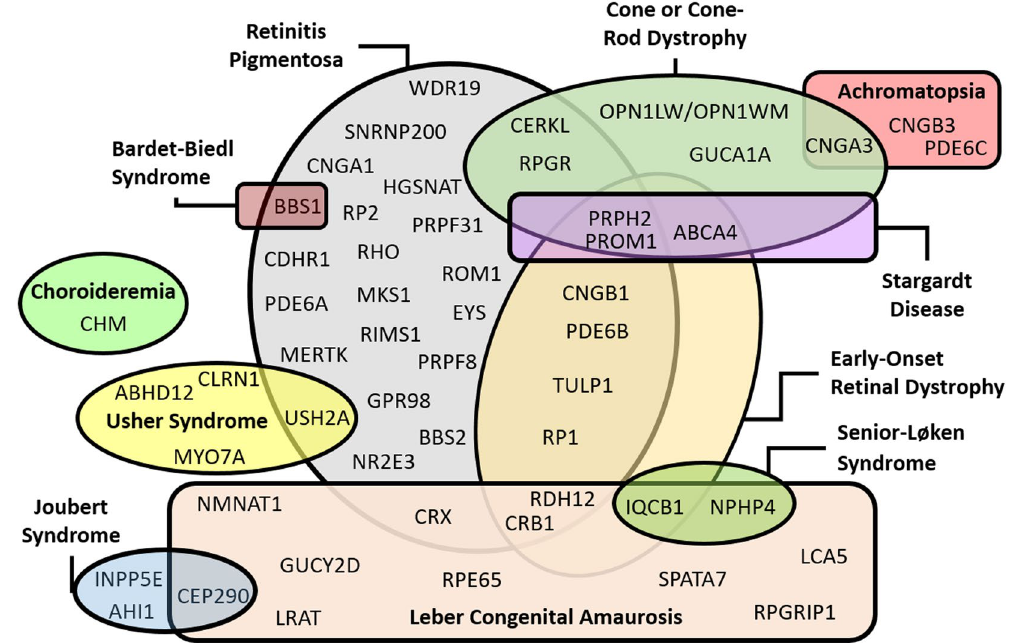
Figure 3. The diagram summarizes the genetic findings in the Brazilian sample and highlights the genetic overlap among some